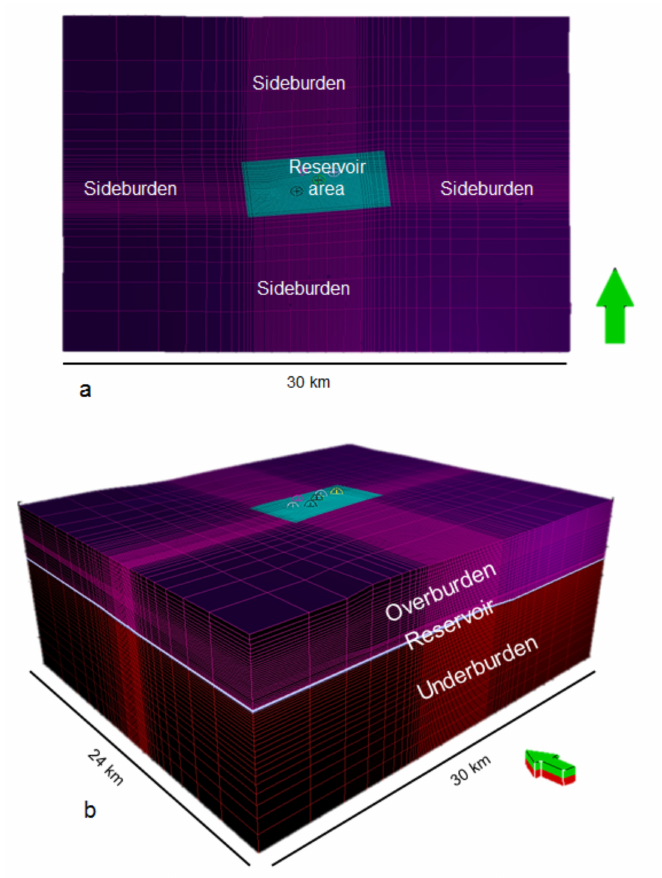
Figure 8. Reservoir model proper embedded in 3D geomechanical model with reservoir, overburden, underburden, and sideburden zones. ( a ) is the top view and ( b ) is the oblique view (arrows point